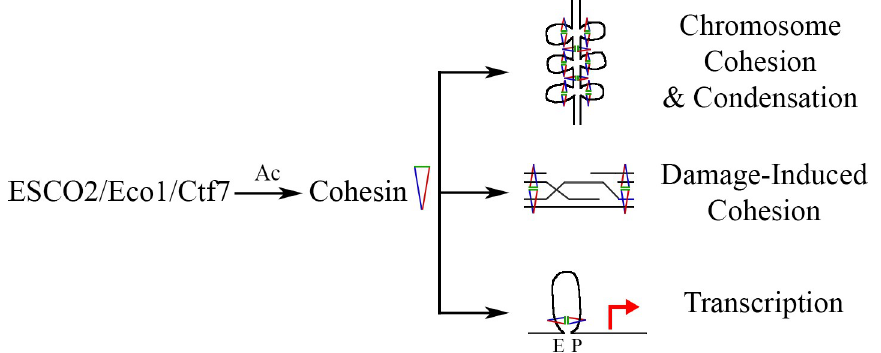
Fig 1. ESCO2 regulates genome structure, function, and stability. ESCO2 (Eco1/Ctf7 in yeast) is an acetyltransferase that modifies cohesin proteins during chromosome cohesion and condensation. Cohesin acetylation drives DNA damage-induced cohesion, which brings sister chromatids into close physical proximity to promote strand invasion during homologous recombination. ESCO2 acetylates cohesin to regulate chromatin looping, thereby modulating transcriptional outputs that bring enhancers (E) and promoters (P) into close proximity. Ac, acetylation; Ctf7, chromosome transmission fidelity 7 protein; Ecol, establishment of cohesion 1 protein; ESCO2, establishment of cohesion 2